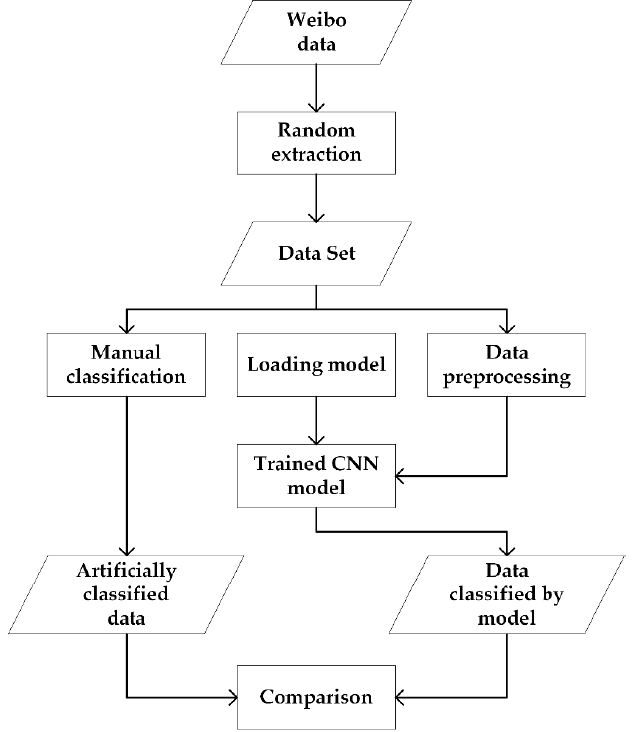
Figure 9. Verification experiment